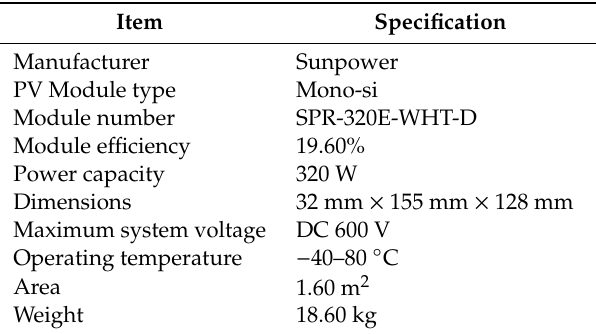
Table 3. Specification of the PV module [19,20].